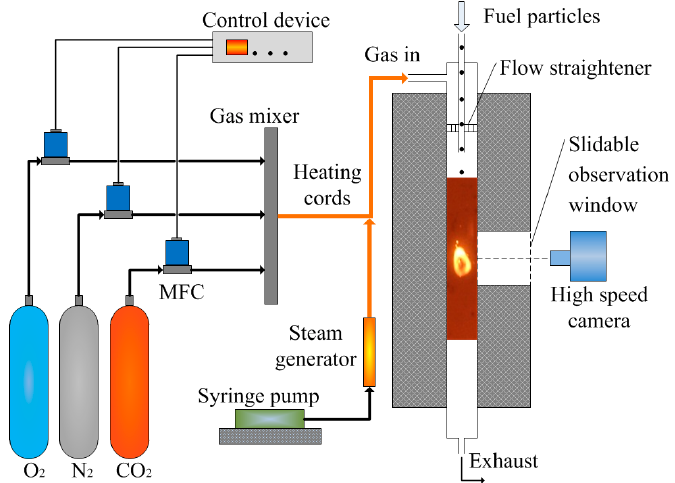
Figure 1. Schematic of the experimental setup.